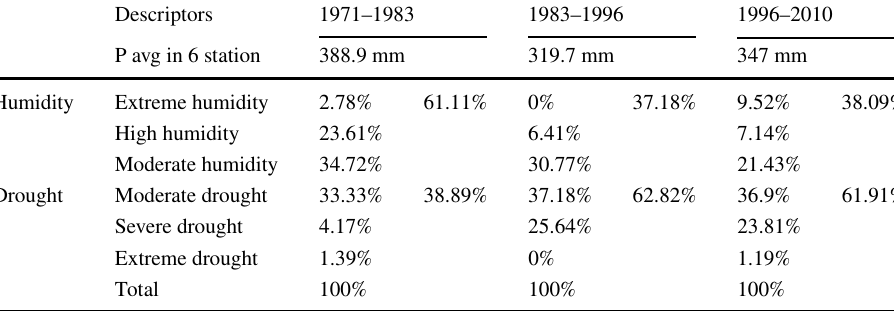
NB: Values are calculated from SPI annual averages at the 6 stations